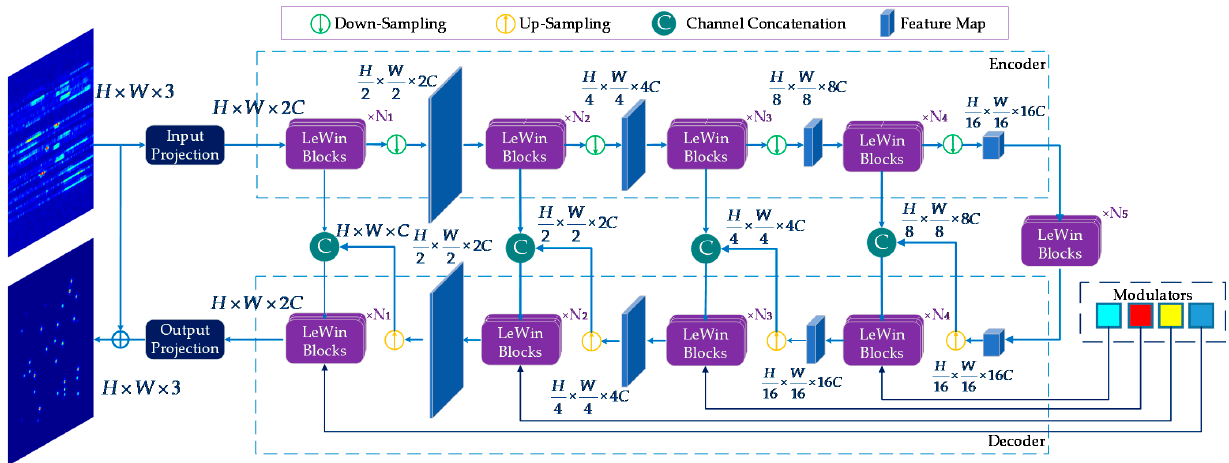
Figure 3. The architecture of the proposed generator.